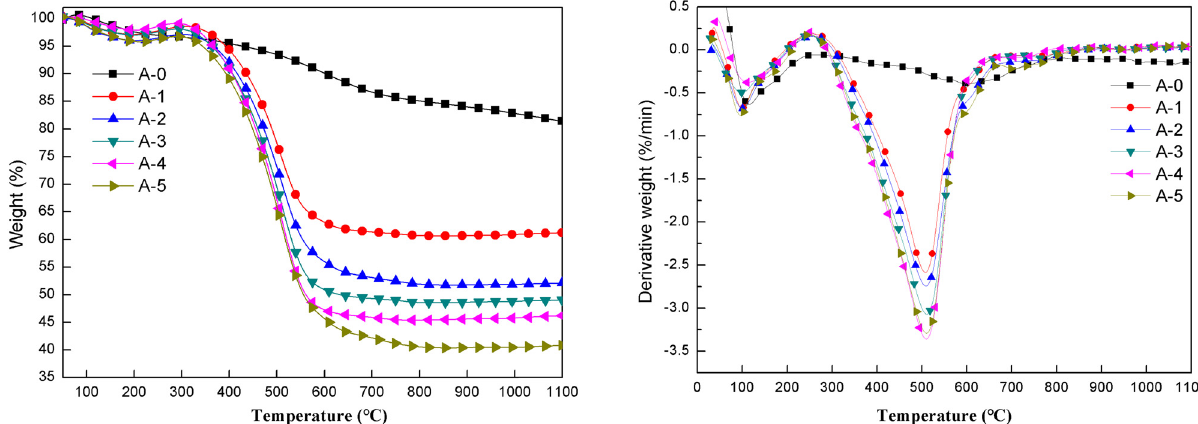
Figure 7: TG and DTG curves of